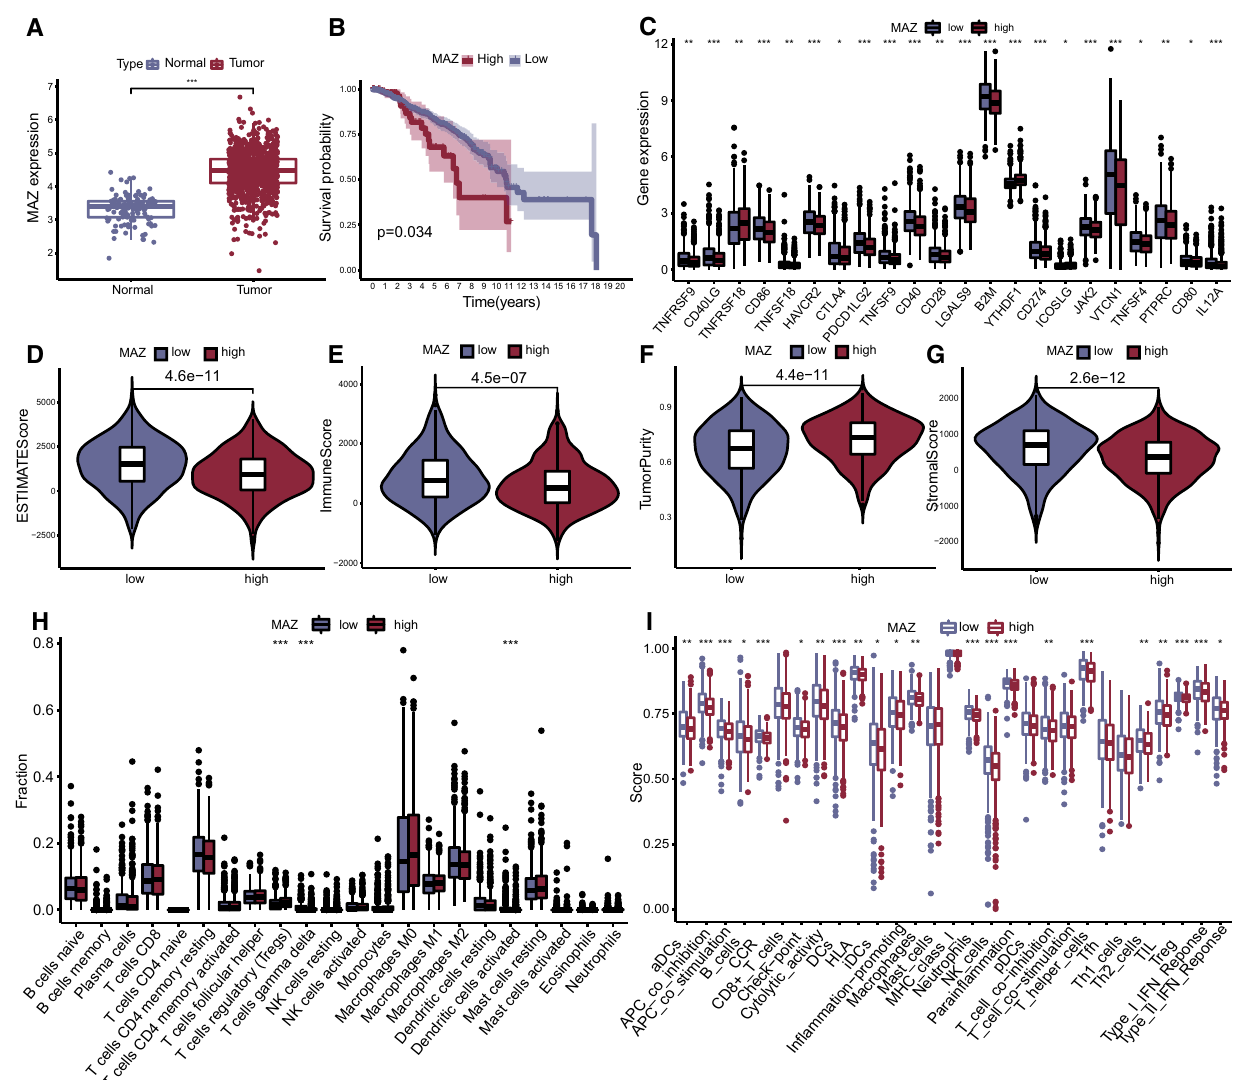
Fig. 5 Screening and analysis of the prognosis-related gene MAZ. A Expression difference of MAZ between tumor and normal tissue in TCGA-BRCA; B KM survival curve of high and low MAZ expression in TCGA-BRCA; C immune checkpoint difference between high and low MAZ expression patients in TCGA-BRCA; D – G Violin plots of ESTIMATE score, immune score, tumor purity, stromal score differences between high and low MAZ expression patients; H) Box plot of CIBERSORT results in high and low MAZ expression; I Box plot of ssGSEA results in high and low MAZ expression. (*p < 0.05, **p < 0.01, ***p <